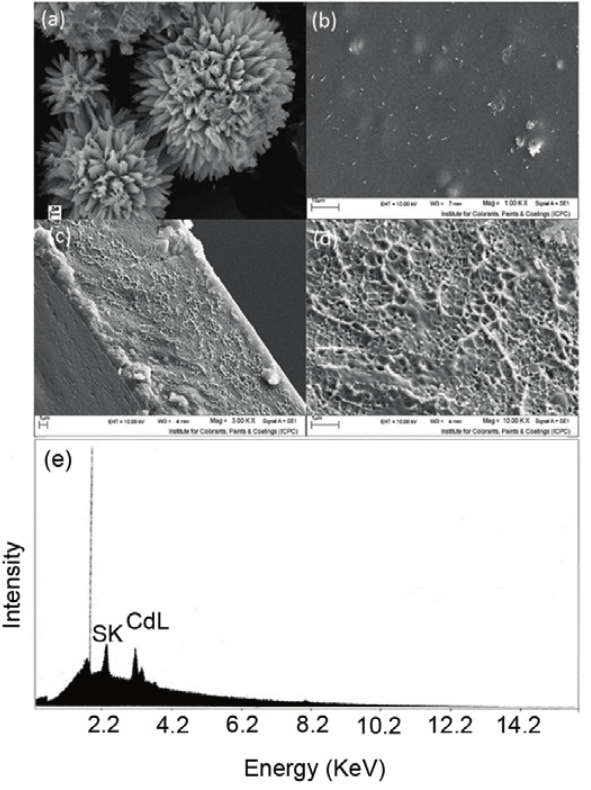
Figure 2. SEM images of (a) flowerlike CdS-or (b) ABS/CdS-or nanocomposite, (c) and (d) cross sectional SEM image of ABS/CdS-or nanocomposite (e) EDX anal- ysis of ABS/CdS-or nanocomposite.